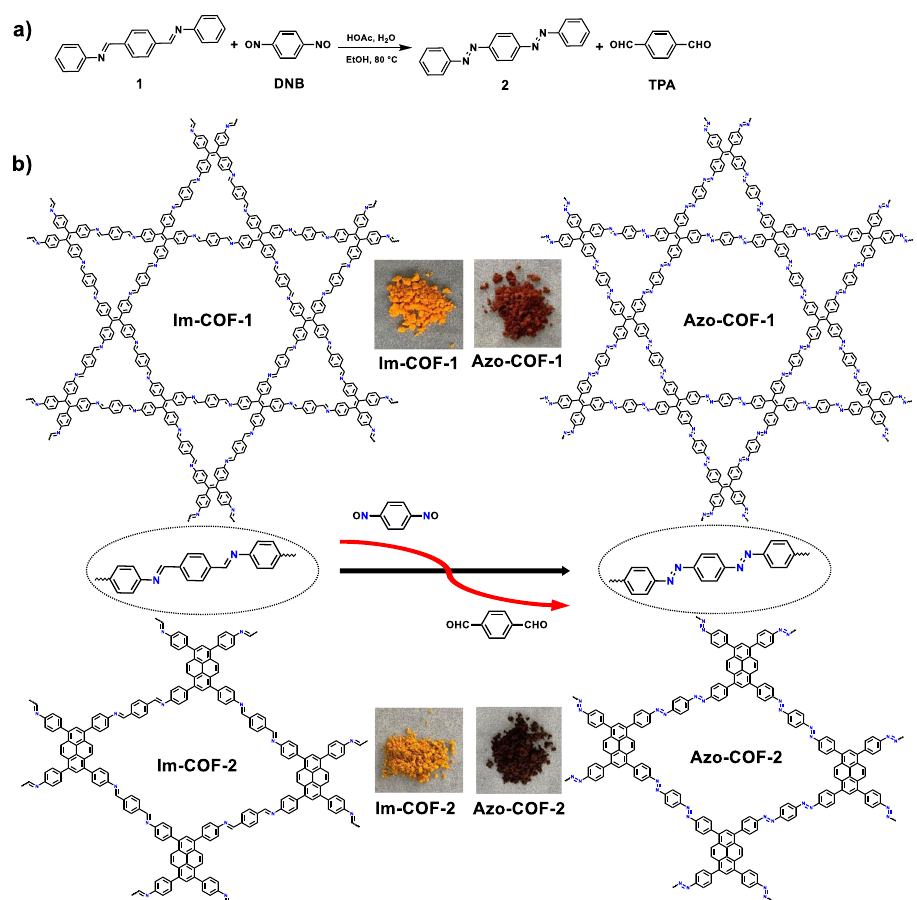
Fig. 1 Schematic diagram for the linker-exchange strategy. a Model reaction. b Fabrication of azo-linked COFs via linker